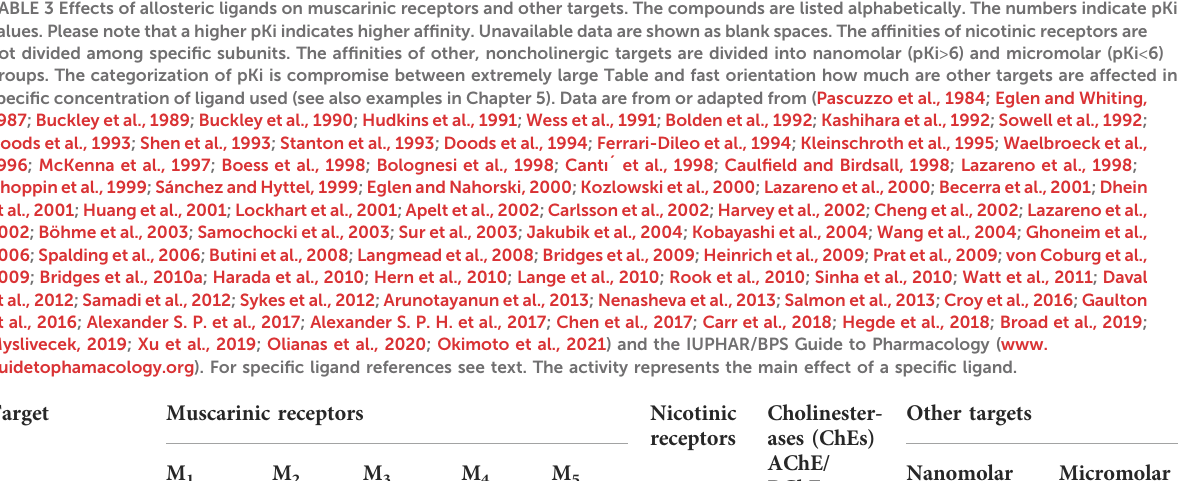
TABLE 3 Effects of allosteric ligands on muscarinic receptors and other targets. The compounds are listed alphabetically. The numbers indicate pKi values. Please note that a higher pKi indicates higher af fi nity. Unavailable data are shown as blank spaces. The af fi nities of nicotinic receptors are not divided among speci fi c subunits. The af fi nities of other, noncholinergic targets are divided into nanomolar (pKi > 6) and micromolar (pKi < 6) groups. The categorization of pKi is compromise between extremely large Table and fast orientation how much are other targets are affected in speci fi c concentration of ligand used (see also examples in Chapter 5). Data are from or adapted from (Pascuzzo et al., 1984; Eglen and Whiting,